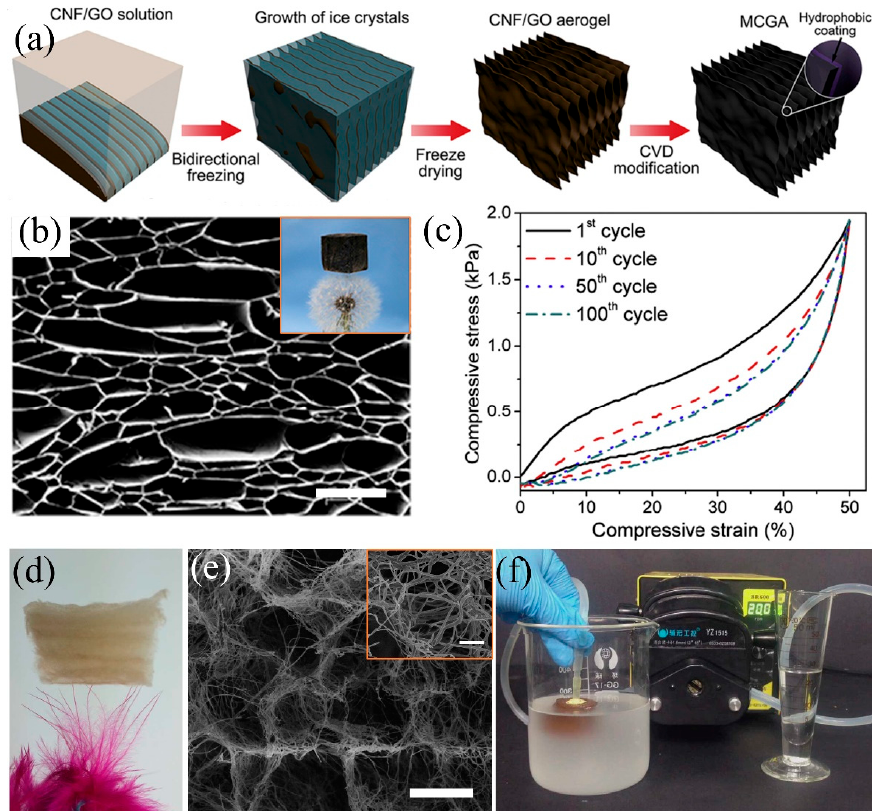
Figure 13. ( a ) Schematic diagram of the bidirectional freeze ‐ drying process to prepare the cellulose ‐ graphene composite aerogel, ( b ) SEM image of the cellulose ‐ graphene aerogel (the insert is the photograph of aerogel on the dandelion), ( c ) elastic cycle performance of aerogels by 100 cycles [64]; reproduced with permission from Elsevier. ( d ) Photograph of the cellular aerogel on the feather, ( e ) SEM image of the cellular aerogels, ( f ) illustration of continuous oil ‐ in ‐ water emulsion separation by cellular aerogel [196]; reproduced with permission from Nature.